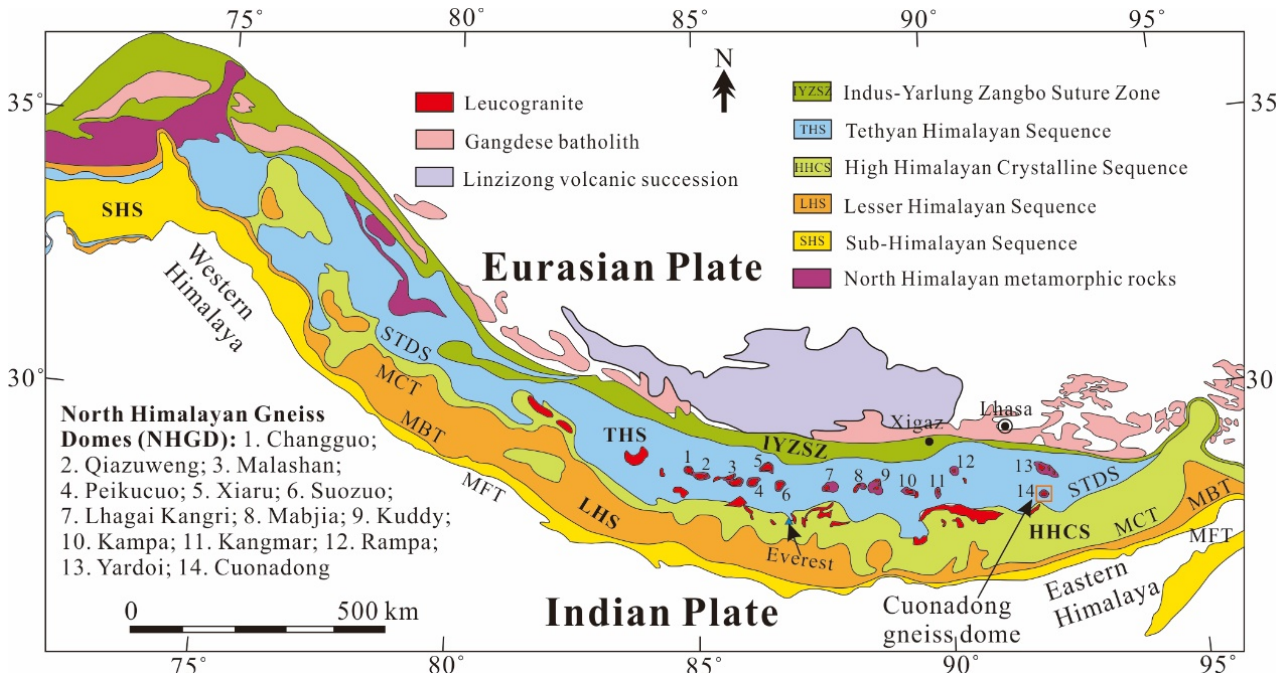
Figure 1. Simplified geological map showing the distribution of the Himalayan leucogranite, gneiss dome, and tectonic zones (modified after [3,10,52]).